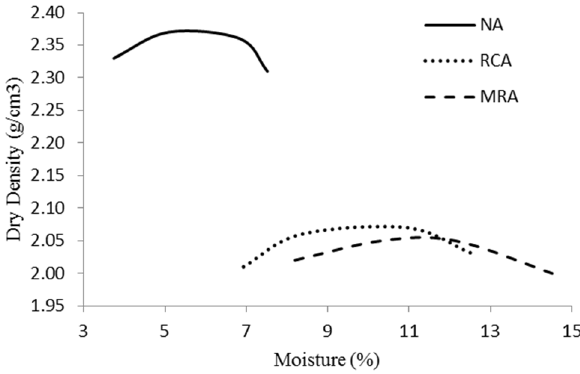
Figure 2. Modified Proctor curves for the three materials. Table 3. Optimum moisture content and maximum dry density: Modified Proctor test.